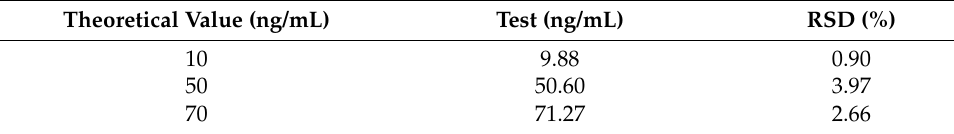
Table 3. Detection of T-2 toxin in real samples.